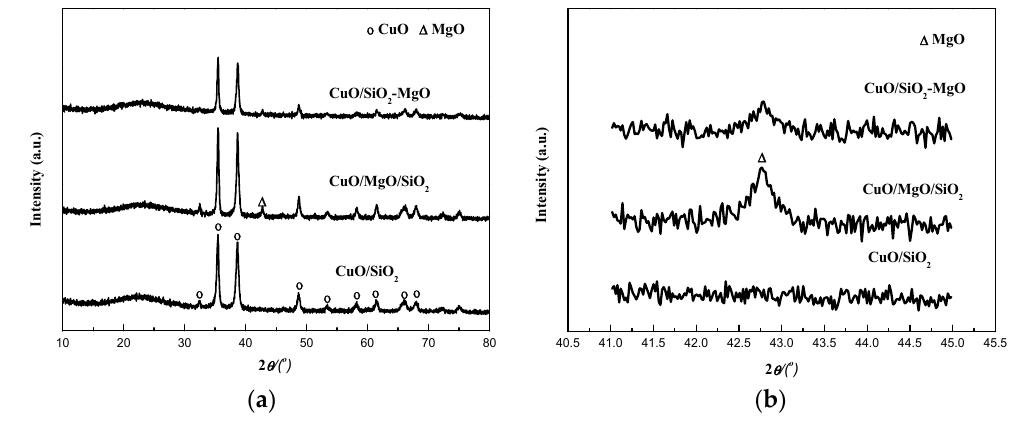
Figure 6. XRD patterns of the catalysts.